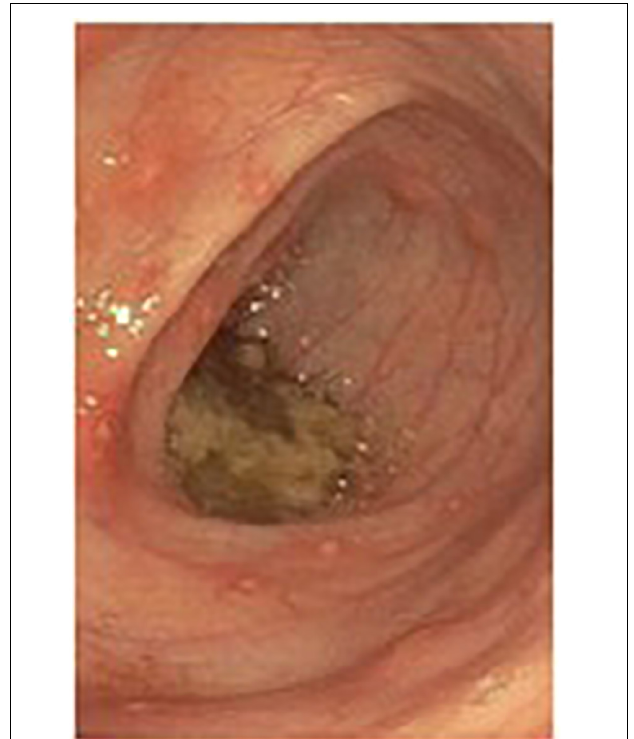
FIGURE 2 | Erosions seen in the descending colon on